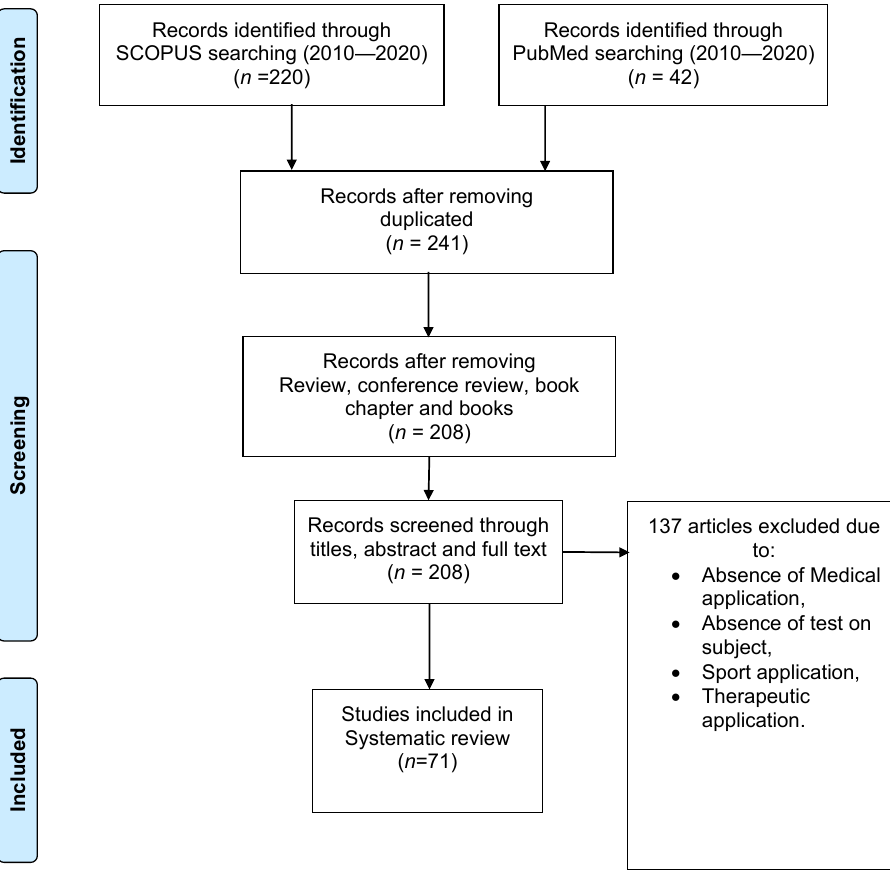
Figure 1. Flow chart for selecting papers from Scopus and Pubmed databases. The articles were categorized into conference papers and articles, Industrial Bioengi- neering (IB), and ICT domains. Figure 2 depicts the proportions.